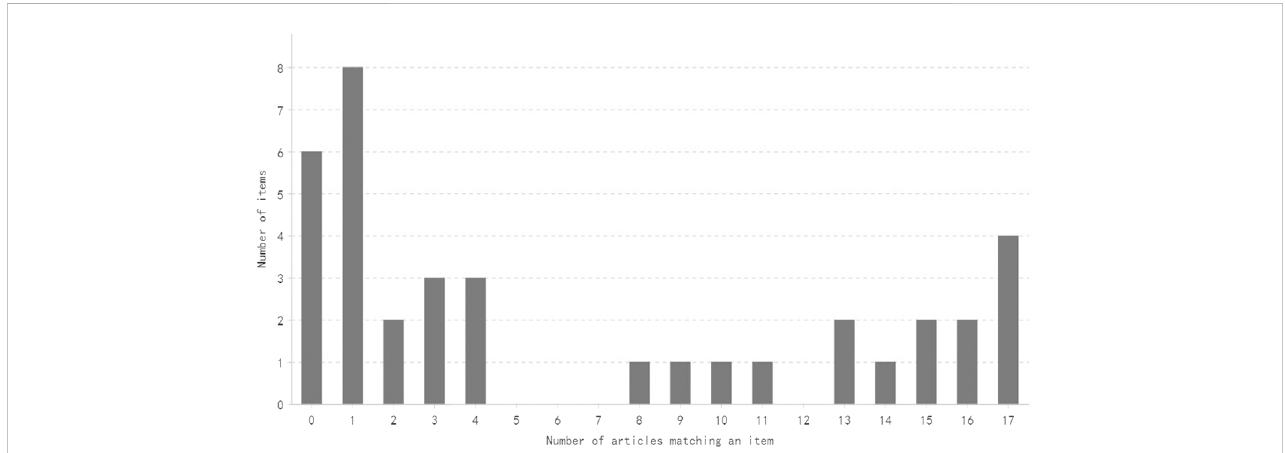
FIGURE 2 Distribution of the number of CONSORT items satis fi ed by a speci fi c number of